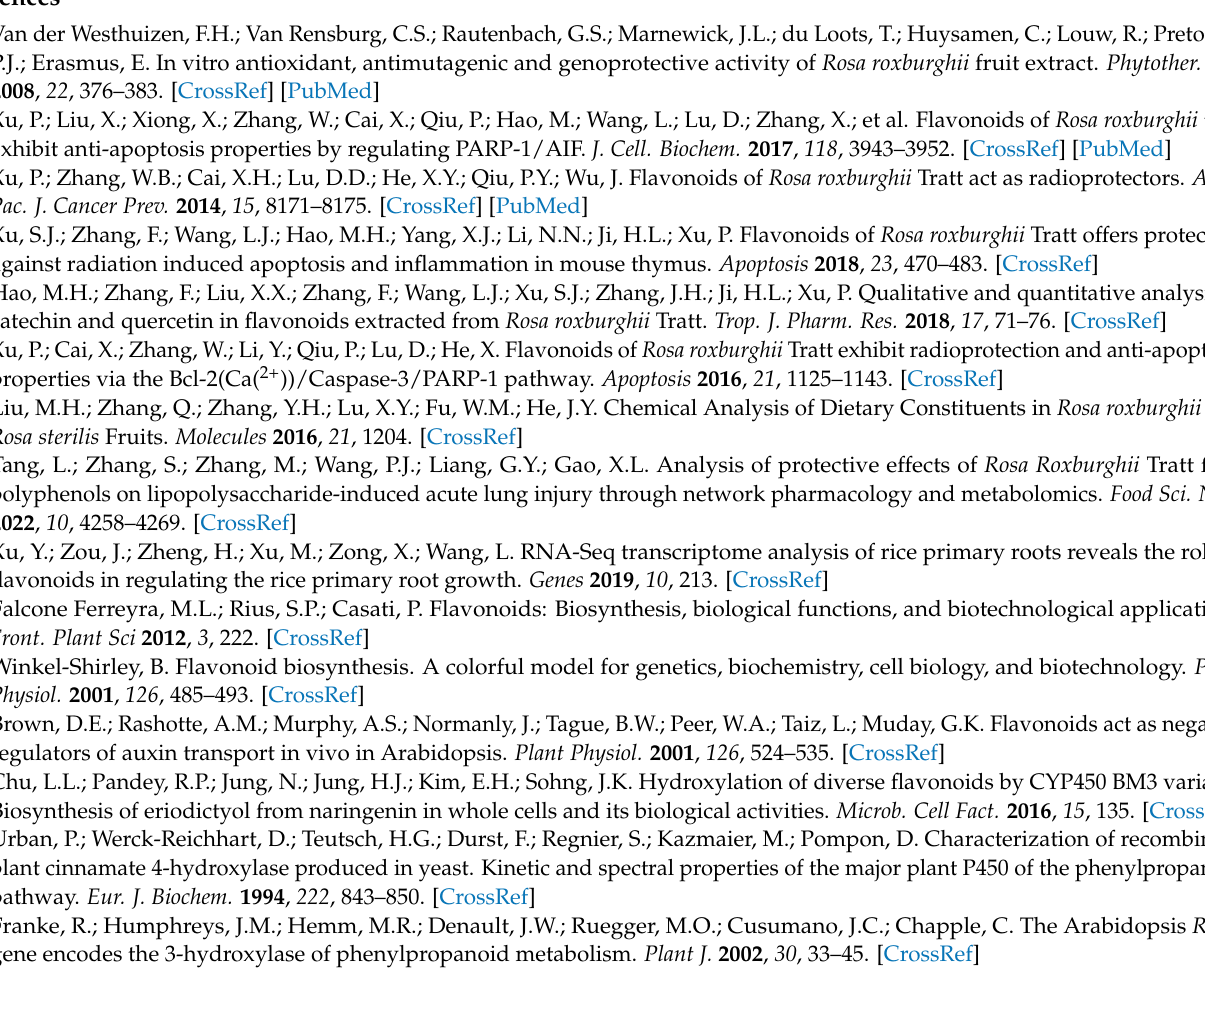
Table S3. The transcripts of genes associated with transporters in five tissues; Table S4. The number of unigenes involved in transporters and transcription factors; Table S5. The expressions of genes related to transcription factors in five tissues; Table S6. The expressions of genes associated with cytochrome P450 in five tissues; Table S7. The list of all genes in “black”, “purple”, “lightgreen”, “blue”, “green” and “yellow”